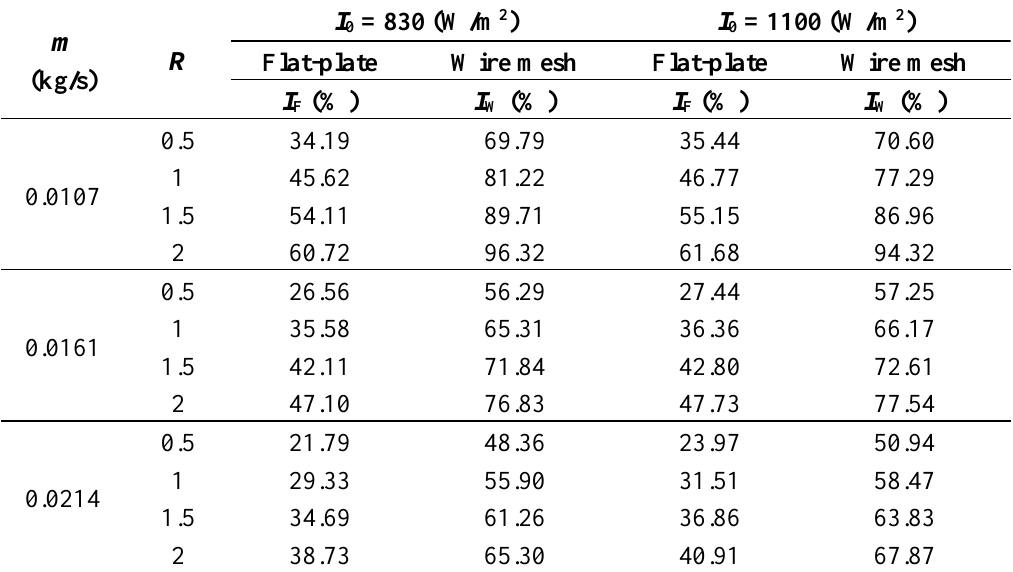
Table 4. Theoretical predictions of heat-transfer efficiency improvement of I F and I W .